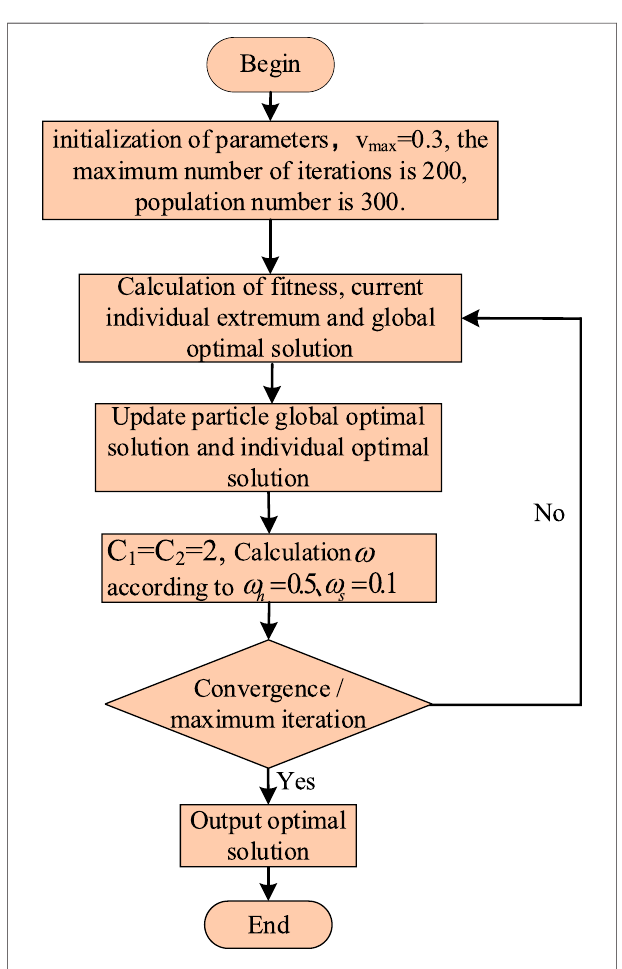
FIGURE 2 | Improved PSO optimization fl ow